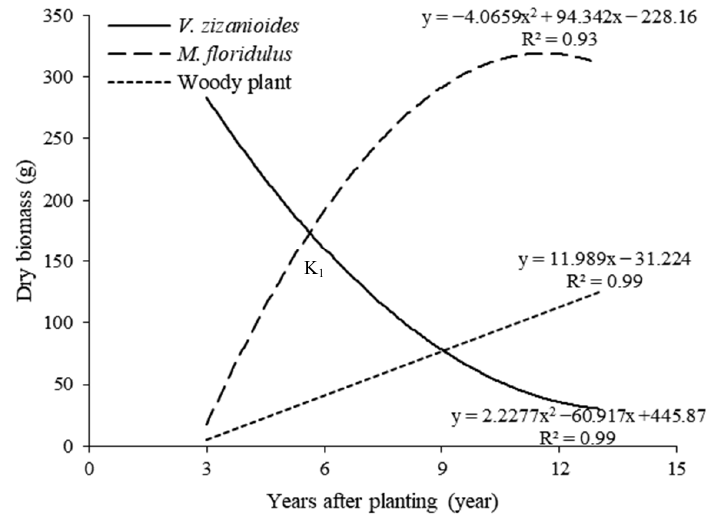
Figure 4. Dry biomass changes of V. zizanioides , M. floridulus, and woody plants in different years after planting.